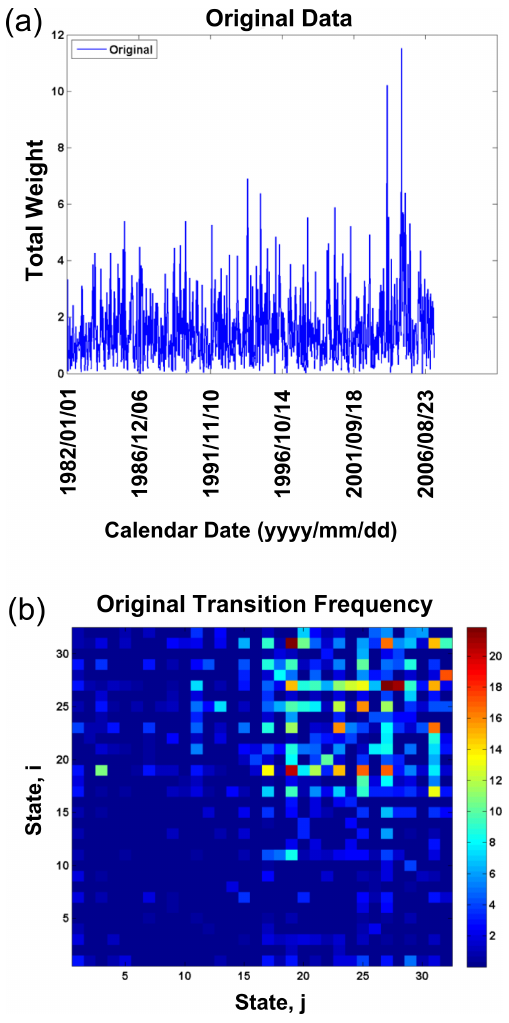
Figure 2. (a) A time series of the state-to-state transition frequen- cies of the modified Markov chain model of the earthquake sequenc- ing. The sampling time ( (cid:49)t ) of 9 days is used. (b) The state-to-state transition frequencies of the modified Markov chain model of the earthquake